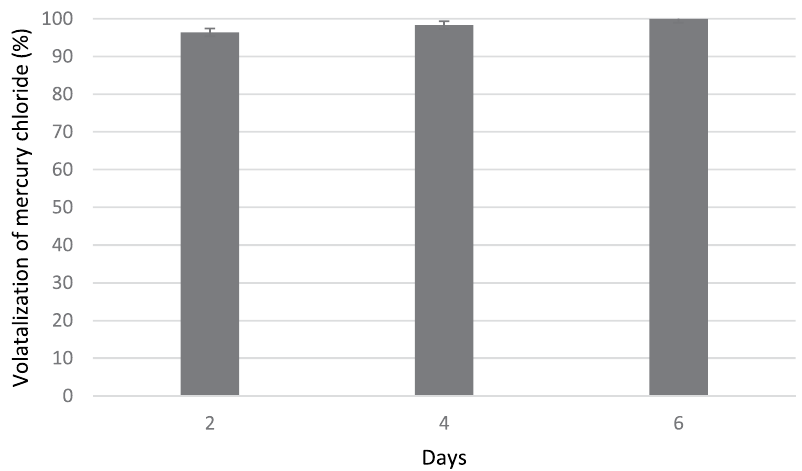
Fig. 4. Mercury bioconversion (%) by UC07 clone on day 2, 4 and 6 on Ulhas soil (actual site)